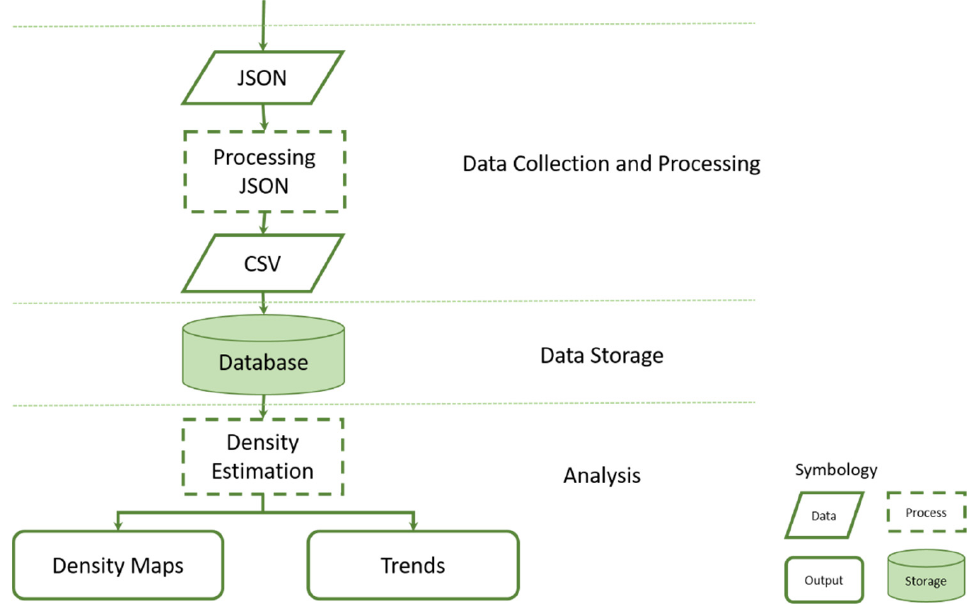
Figure 2. The process flow for data collection and analysis.